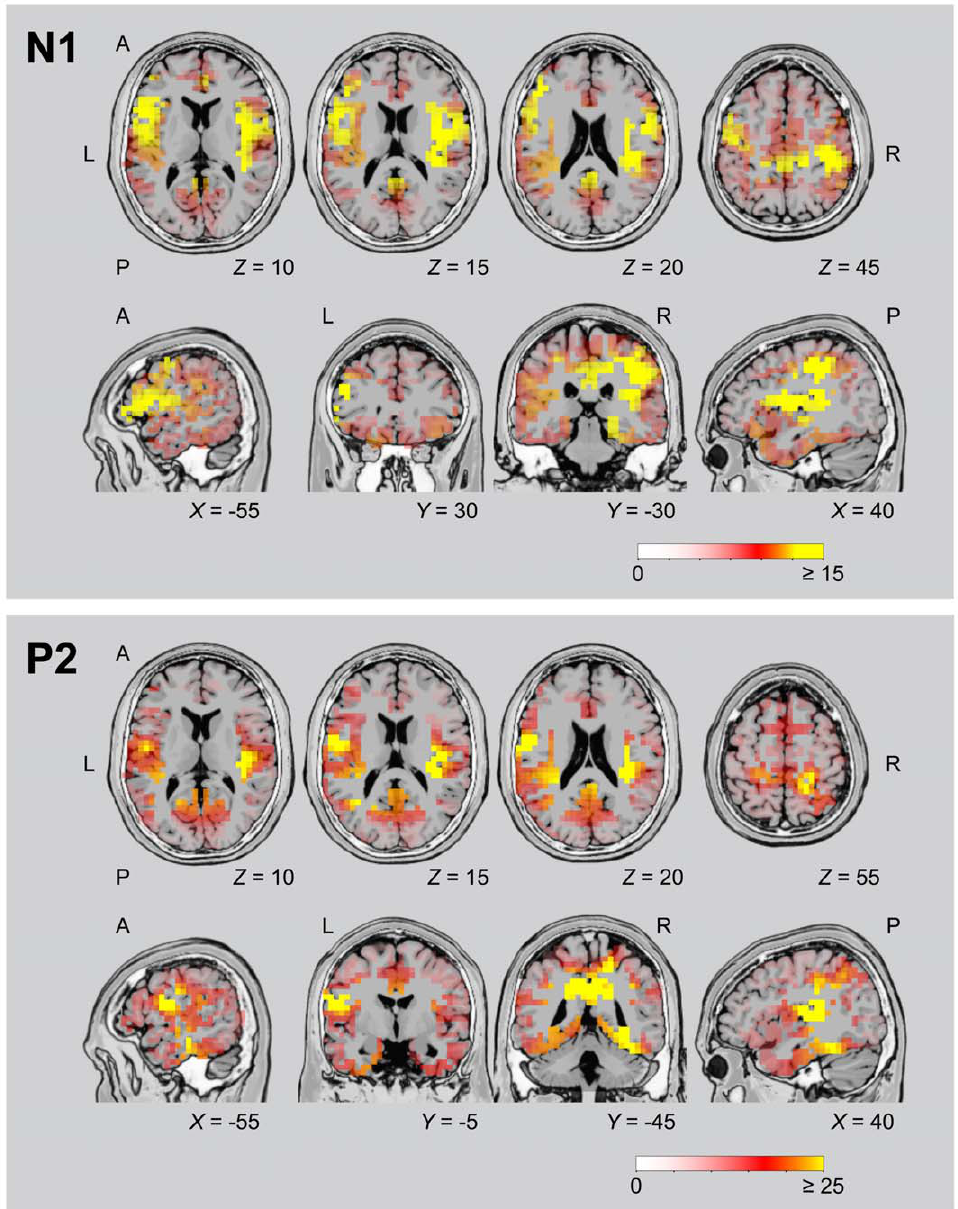
Figure 2. Peak activations of brain regions for all sound locations, as revealed by sLORETA analysis. Activations at the time of the N1 and P2 components of the responses to the sound onset were contrasted with a 40-ms prestimulus period of silence. Colour coding shows t -values, with statistically significant activations ( p , 0.05) at t $ 4.1 for N1 and t $ 3.6 for P2. Data from all subjects were projected onto a single anatomical image (T2 MNI-template ‘‘Colin 27’’ of sLORETA). Horizontal and coronal slices were positioned at MNI Z and X coordinates as given in the figure (A, anterior; L, left; P, posterior; R, right). Data are as given in Table 2. doi:10.1371/journal.pone.0025146.g002 (see Figs. 5, 6; Table 3). The contrast of central versus eccentric right eccentric) were analyzed separately, and contrasts between sound locations only revealed one right-hemisphere cluster of these conditions were computed using the statistical non- activated voxels for the N1 response, which was located in the parametric mapping tools of the sLORETA software package border area of precuneus and cingulate gyrus (BA 31). No (Fig. 5; Table 3). The contrast of left versus right sound locations significant contrasts of left versus right sound locations or central for the N1 deflection revealed prominent bilateral activations in vs. eccentric sound locations were found for the P2 response. primary auditory cortex (BAs 41, 42), pSTG (BA 22), IPL (BA 40), and insula (BA 13), as well as unilateral activations in right As the ROI analyses described above (cf. plots in Fig. 4) as well as precentral gyrus (BA 6) and in the left temporo-occipital region previous fMRI findings [22] indicated complex interactions between (BA 19). This contrast showed a clear-cut contralaterality pattern, hemispace and eccentricity sensitivity, we finally computed the with opposing signs of voxel values in left and right hemispheres contrast of left central minus right central sound locations versus left